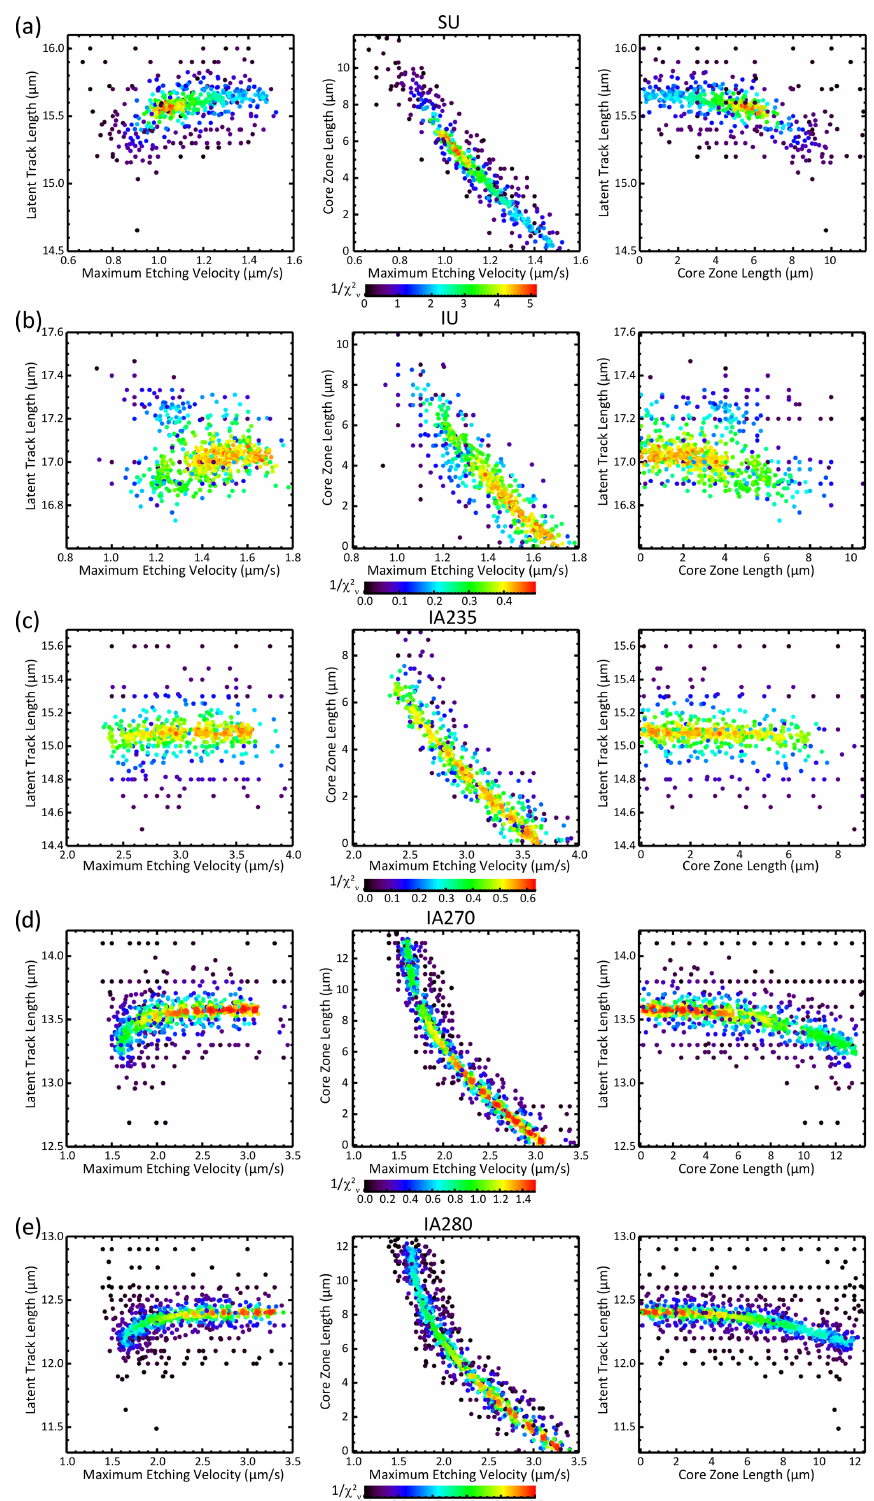
Figure 13. Constant-core model parameter fits for each track type, showing correlations between variables. Each point represents a set of parameters tested during the fitting process, and colors indicate goodness of fit as 1/ χ 2 ν . Warmer colors indicate better fits, and any value near or above 1 indicates a fit to within the resolution of the